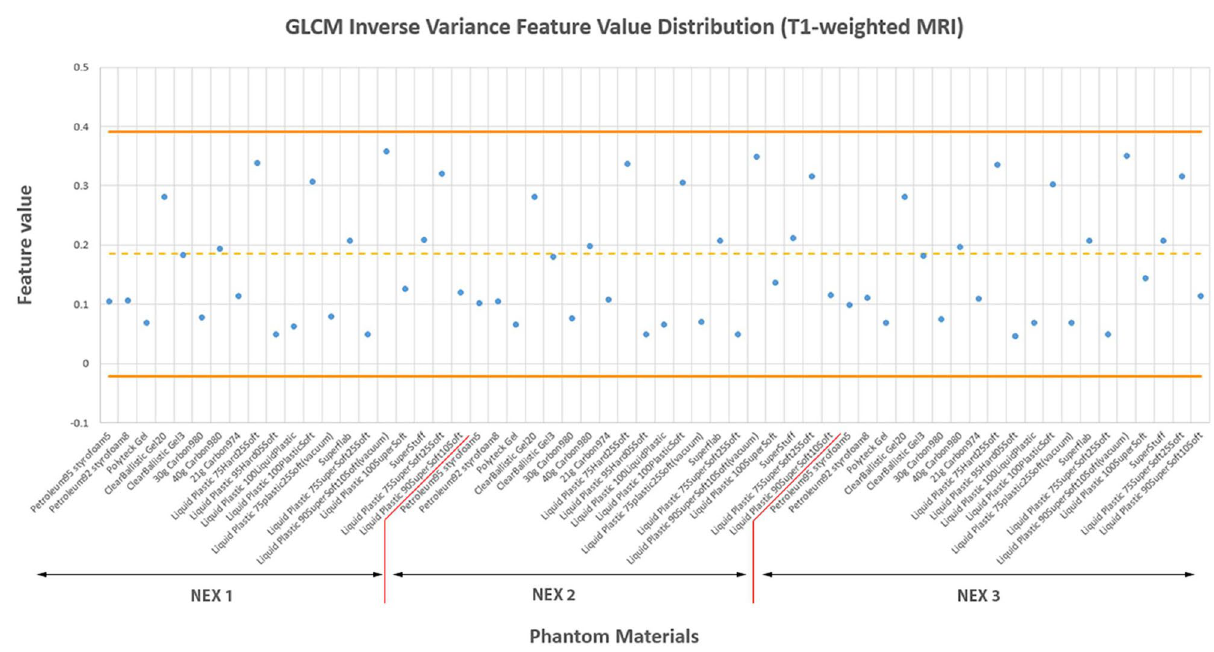
Figure 1. GLCM inverse variance feature values for the MRI phantom materials with various settings in NEX. The orange solid lines and orange dashed line are the mean ± 2 SDs bounds and the mean of the patient population data for the inverse variance feature,